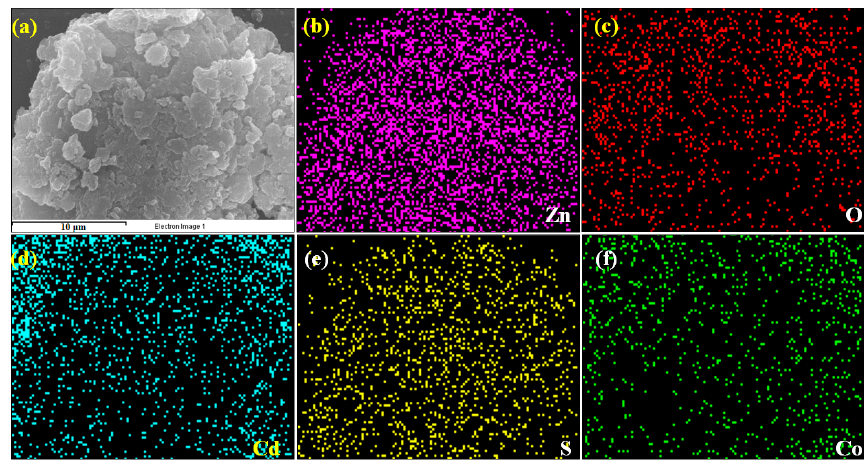
Figure 3. Elemental mapping of Co-doped ZnO/CdS nanosheets. ( a ) Mapping region, ( b ) Zn, ( c ) O, ( d ) Cd, ( e ) S, and ( f ) Co.